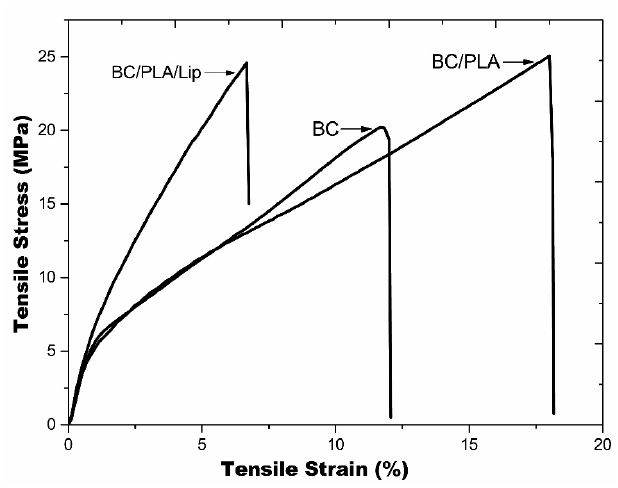
Figure 6. Stress versus Strain plots for BC, BC/PLA, and BC/PLA/Lip nanocomposites. Table 2. Mechanical properties of BC, BC/PLA, and BC/PLA/Lip nanocomposites. Samples